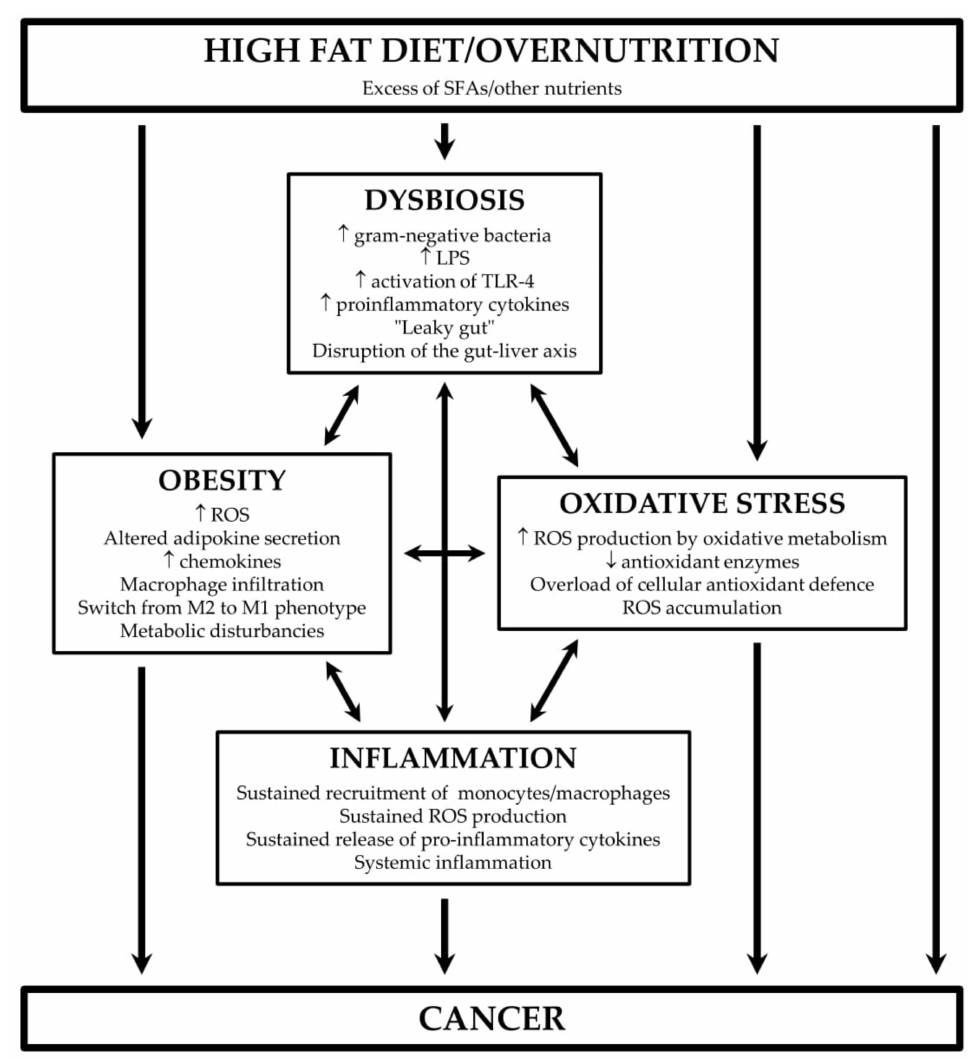
Figure 1. Interplay among disturbances induced by excess of nutrients.